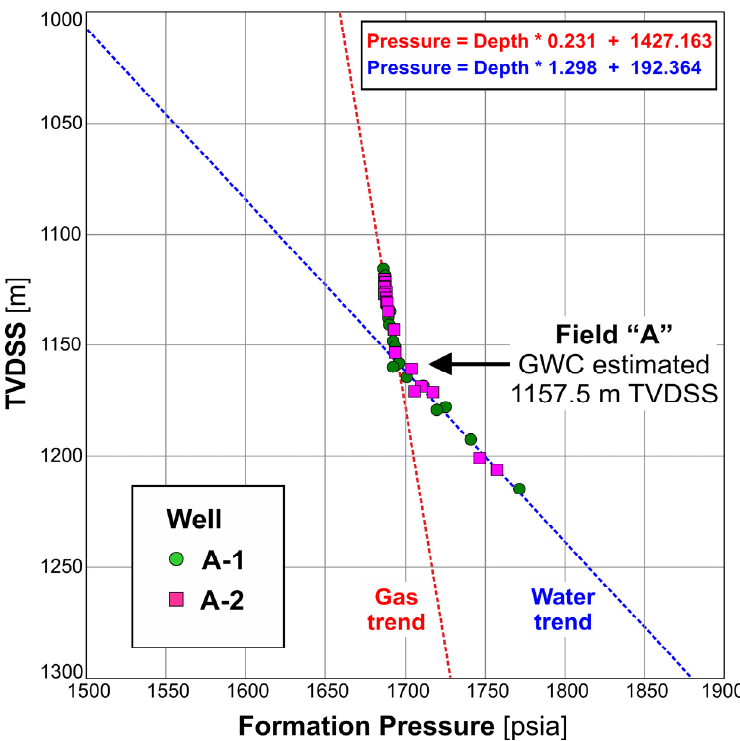
Figure 16. Estimation of gas–water contact (GWC) for field “A” by jointly using pressure measure- ments from available wells.